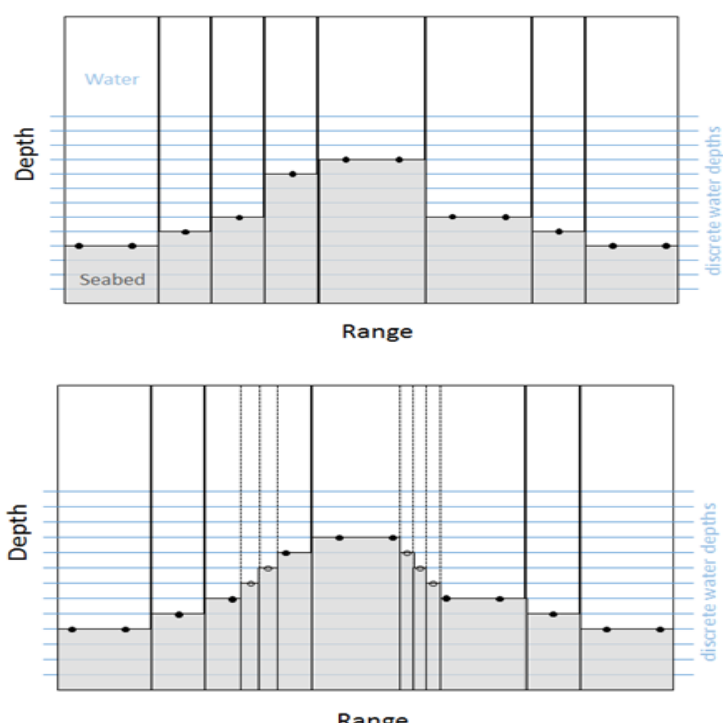
Figure 2. Addition of intermediate grid points in areas of steep bathymetry to comply with the depth discretization step.